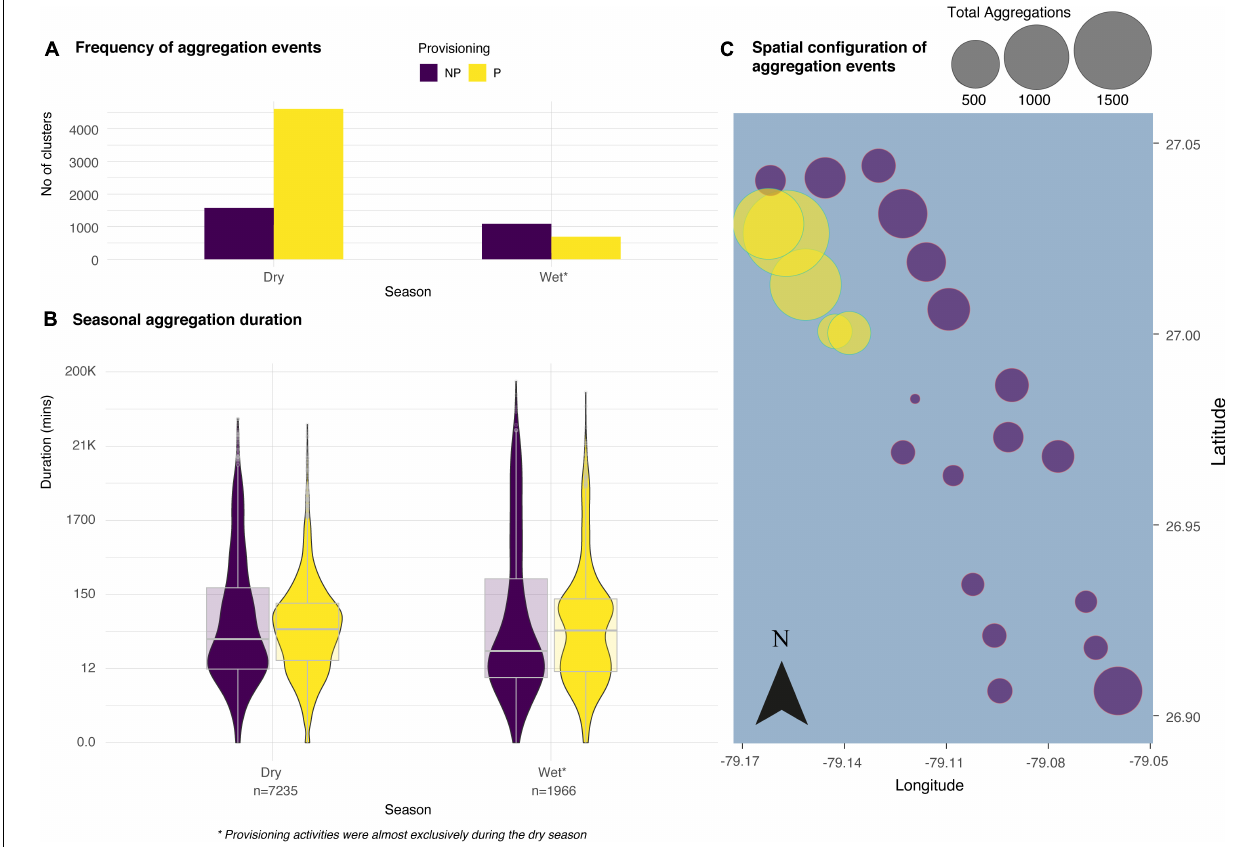
FIGURE 2 | The frequency, duration and configuration of aggregations derived from spatio-temporal clustering events from the GMM between non-provisioned and provisioned sites from data spanning three years. The bar chart (A) reveals more frequent clustering events at provisioned locations and the violin plots (B) illustrate the median, interquartile range, 95% confidence interval and spread of the typical duration (in min, log scale) of aggregations between NP and P ( n represents the number of aggregations per year). No relationship was found between the number of aggregations at each receiver and the distance to the nearest provisioning site (C)